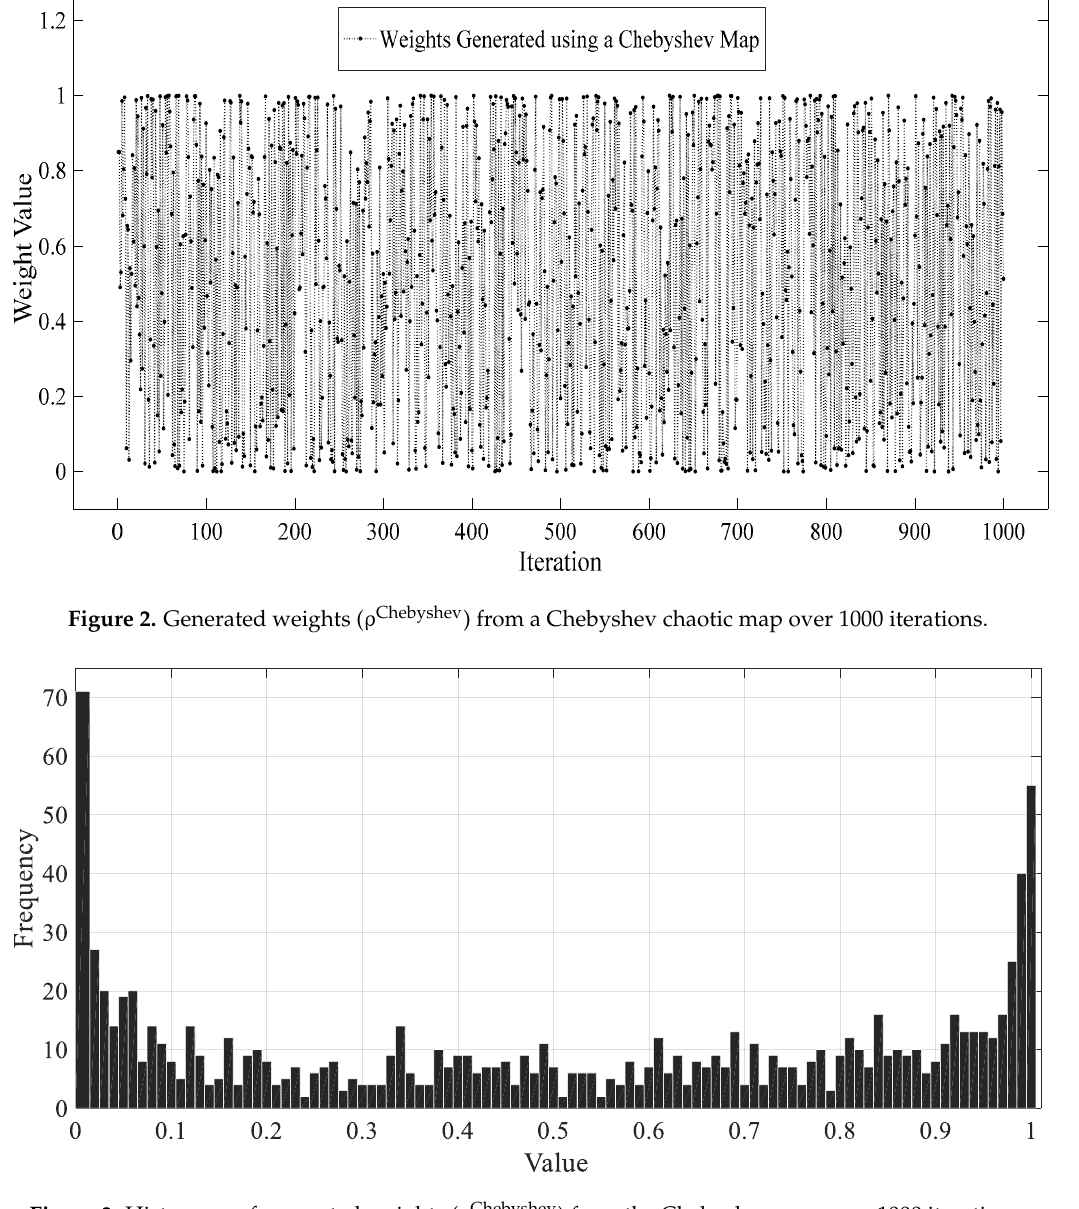
Algorithm 1. Quantum Double Delta Swarm Algorithm